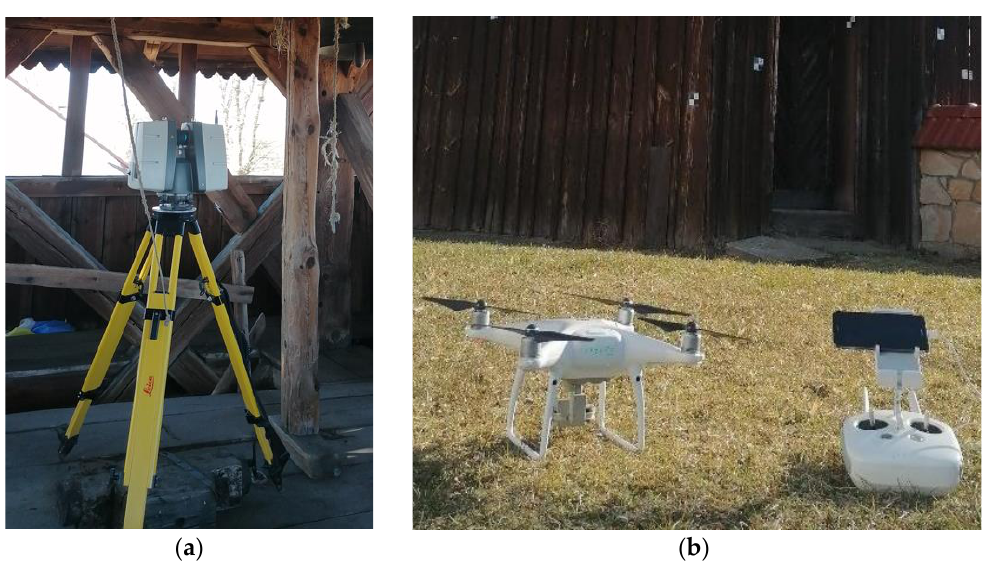
Figure 2. Measuring equipment ( a ) Leica ScanStation P40; ( b ) DJI Phantom 4 Pro with mounted digital camera. digital